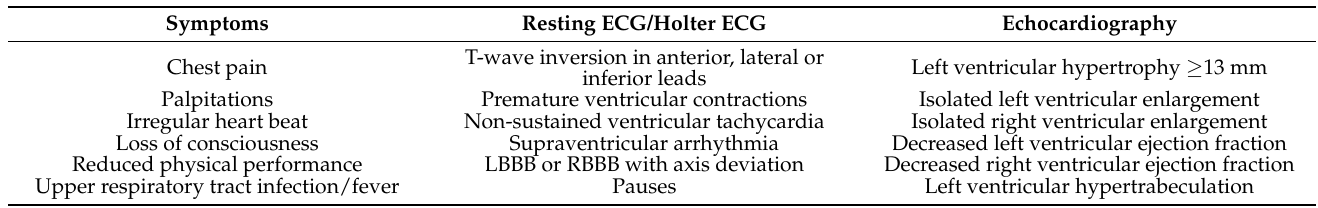
Table 1. The most common symptoms and abnormalities on initial testing leading to CMR. Symptoms Resting ECG/Holter ECG Echocardiography T-wave inversion in anterior, lateral or Chest pain inferior leads